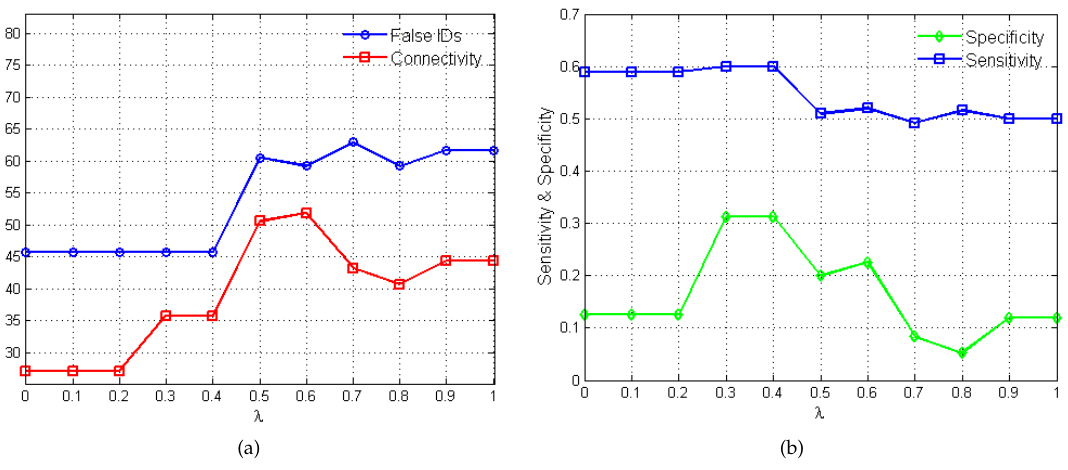
Figure 3. Variations in λ and the corresponding algorithm performance. ( a ) plot of λ versus total number of false identifications and net connectivity in percentages. ( b ) plot of λ versus sensitivity and specificity.